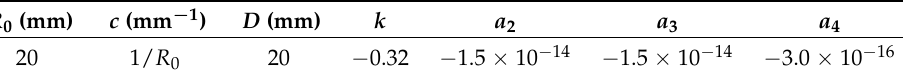
Table 4. Detailed parameters of the aspheric